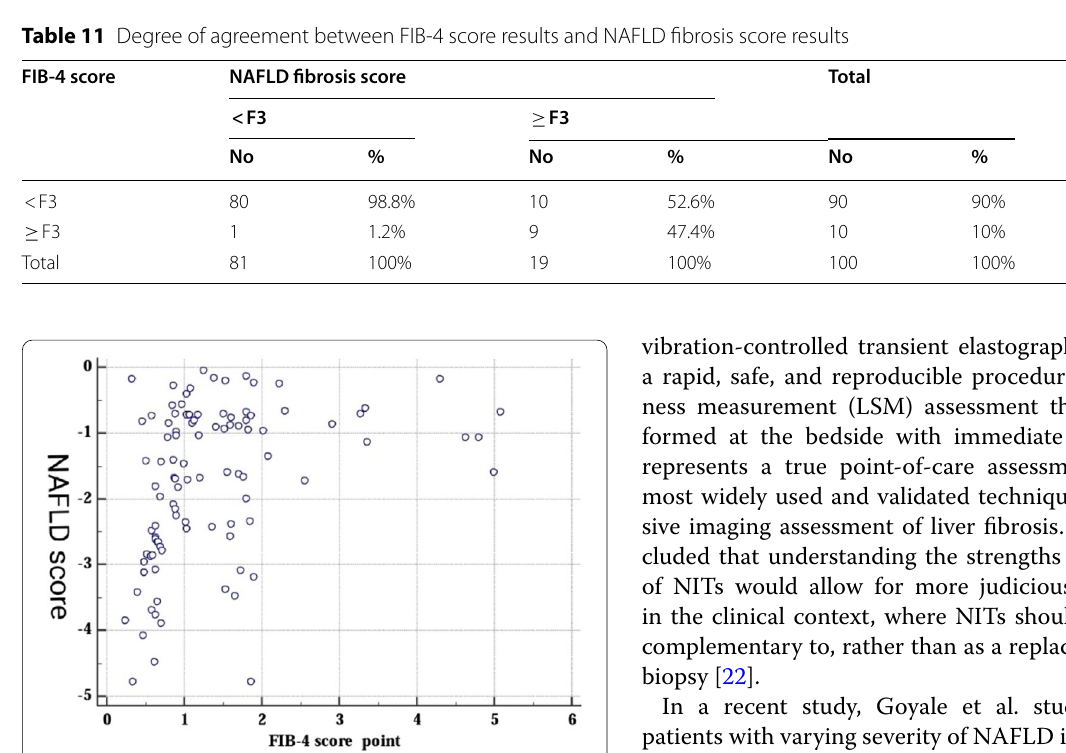
Fig. 3 Scatter graph showing a significant positive correlation (86%) between NAFLD score and FIB-4 score among the patients’